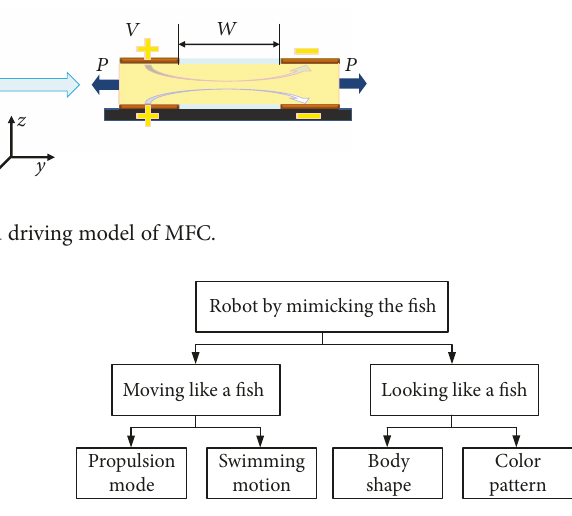
Figure 2: Decomposition of functions for a soft robot mimicking the fi